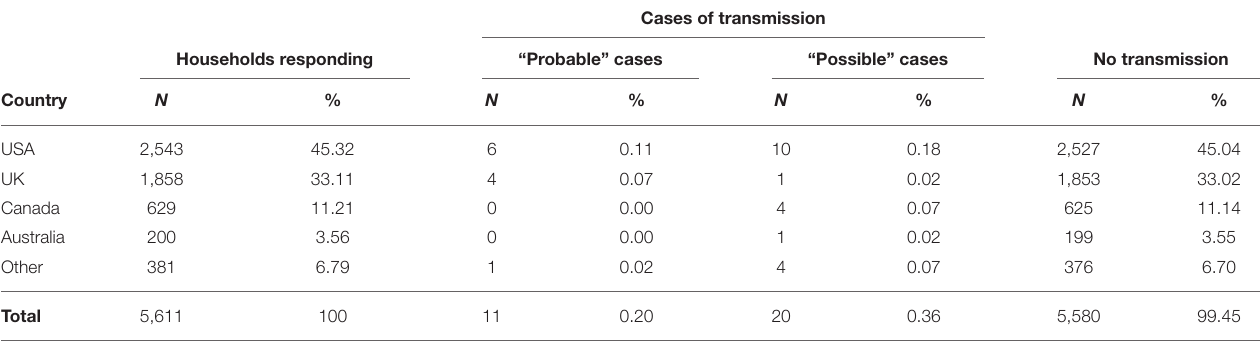
TABLE 1 | Countries responding to the survey with numbers (N) and percentages (%) of respondent households (HHs), “probable” and “possible” cases of transmission and HHs with no transmission reported.